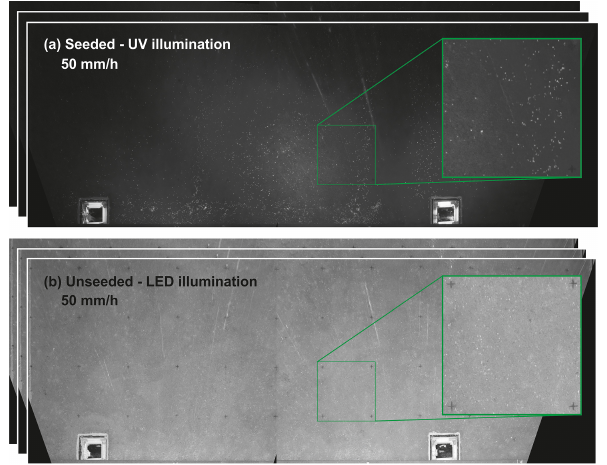
Figure 2. Example of frames used for the assessment of different imaging velocimetry techniques. Images correspond to the two ex- periments performed for the rain intensity of 50mmh − 1 , using flu- orescent particles and UV illumination (a) and using led lamps to highlight water reflections and air bubbles present in the flow (b) .